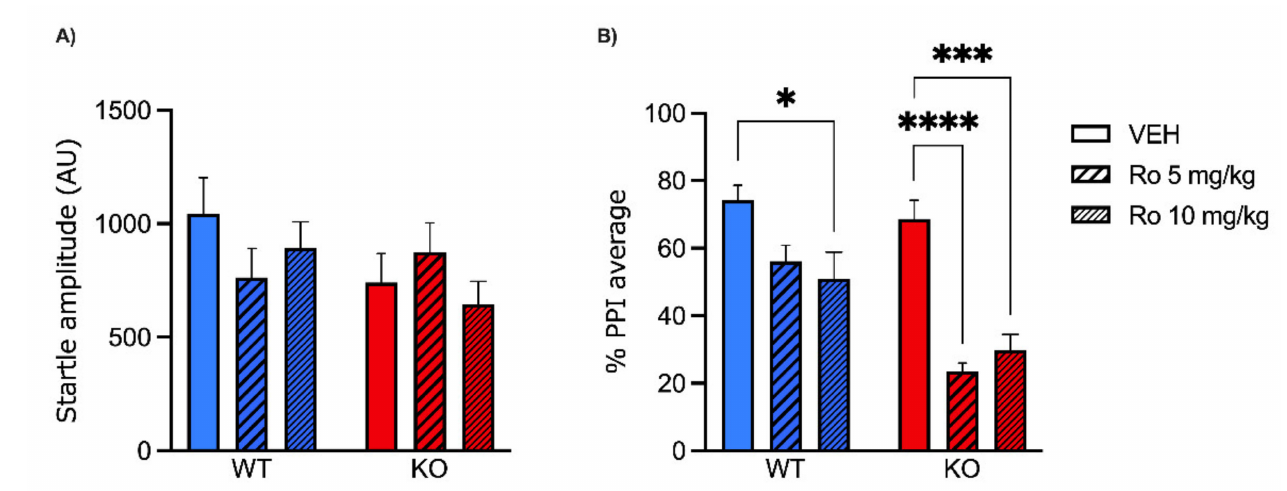
Figure 2. Effects of the NR2B subunit-specific antagonist Ro-256981 (5, 10 mg/kg, IP) on startle reflex ( A ) and prepulse inhibition ( B ) in MAOA KO mice. Data are shown as means ± SEM. Significance levels refer to the results of post hoc comparisons of two-way ANOVA analyses. Main effects are not indicated. * p < 0.05, *** p < 0.001, **** p < 0.0001 for comparisons indicated by bracket lines. (SAL, saline; AU, arbitrary units); n = 6/group. For further details, see results